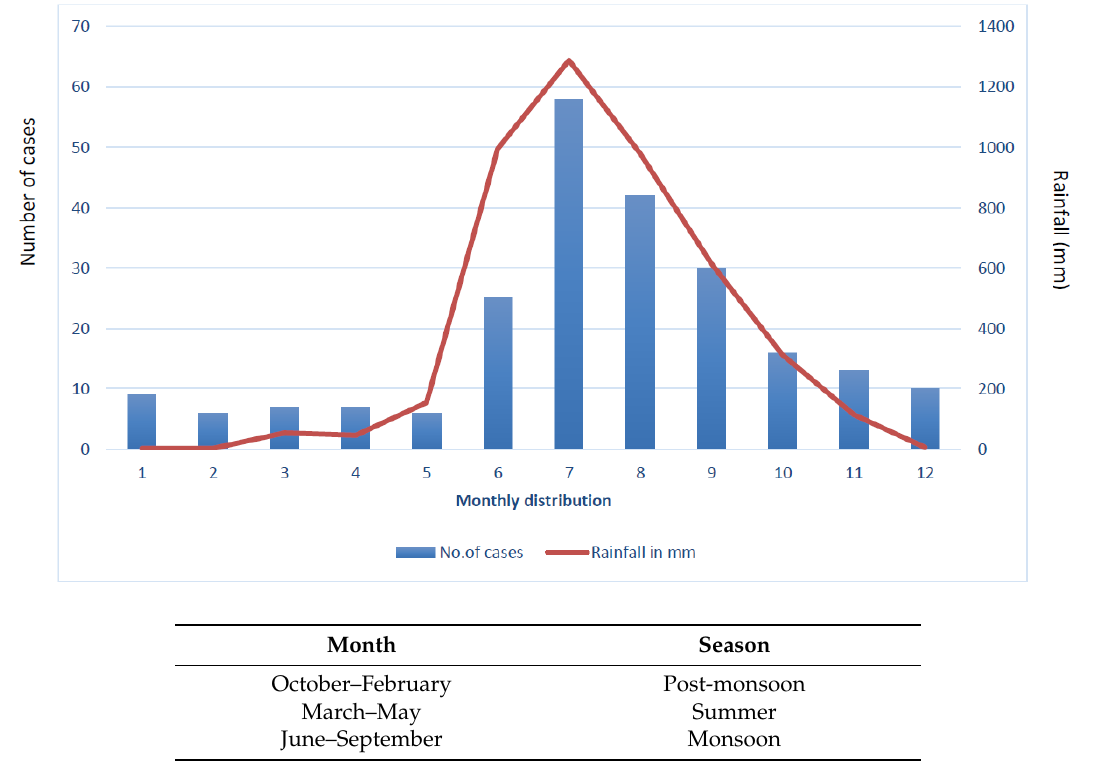
Figure 3. Average monthly rainfall and melioidosis cases in Manipal, 2006 to 2017.